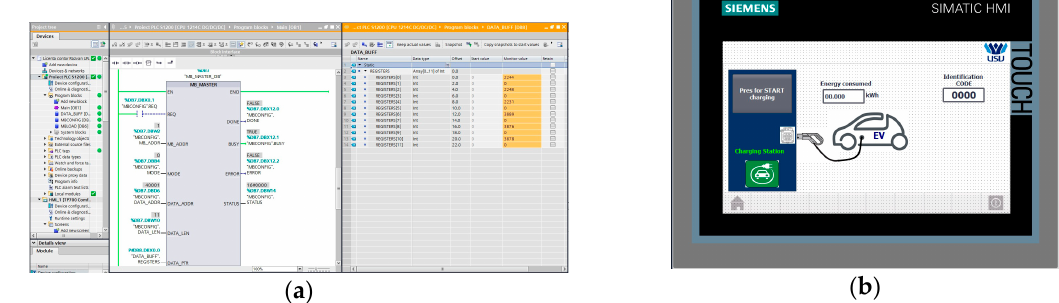
Figure 6. Software application: ( a ) programmable logic controller (PLC) software; ( b ) human-machine interface (HMI) screen.